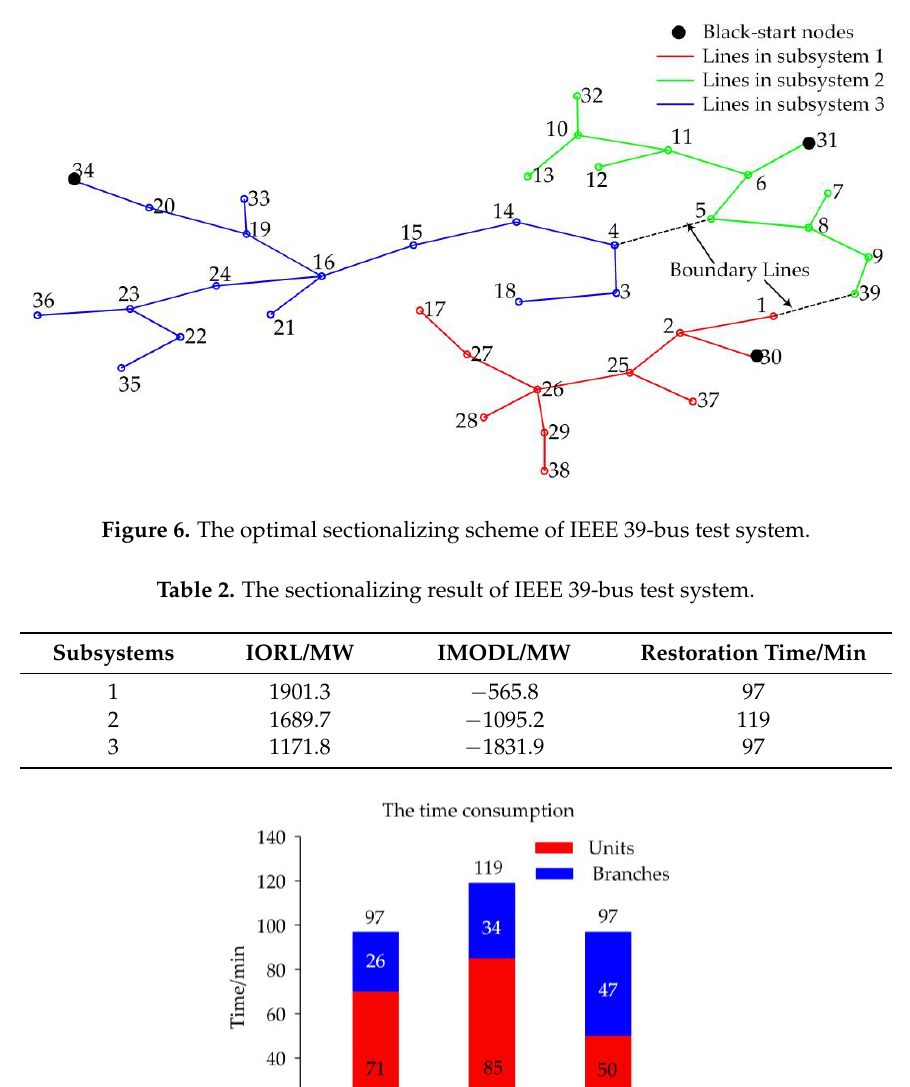
11 of 21 Table 1. The transmission paths connecting all black-start generating units. Index of Path